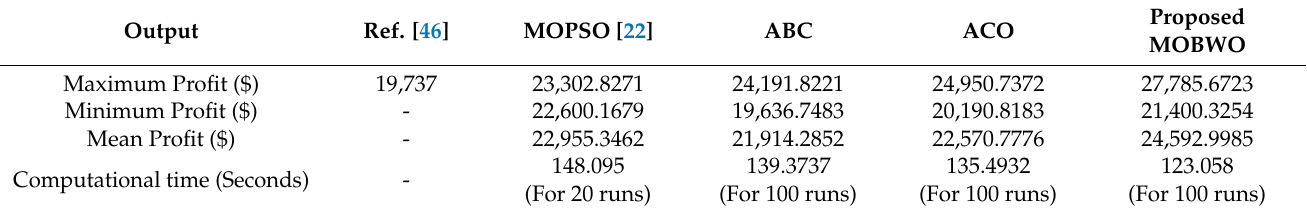
Table 7. Comparison of net profit with different techniques for Case I.